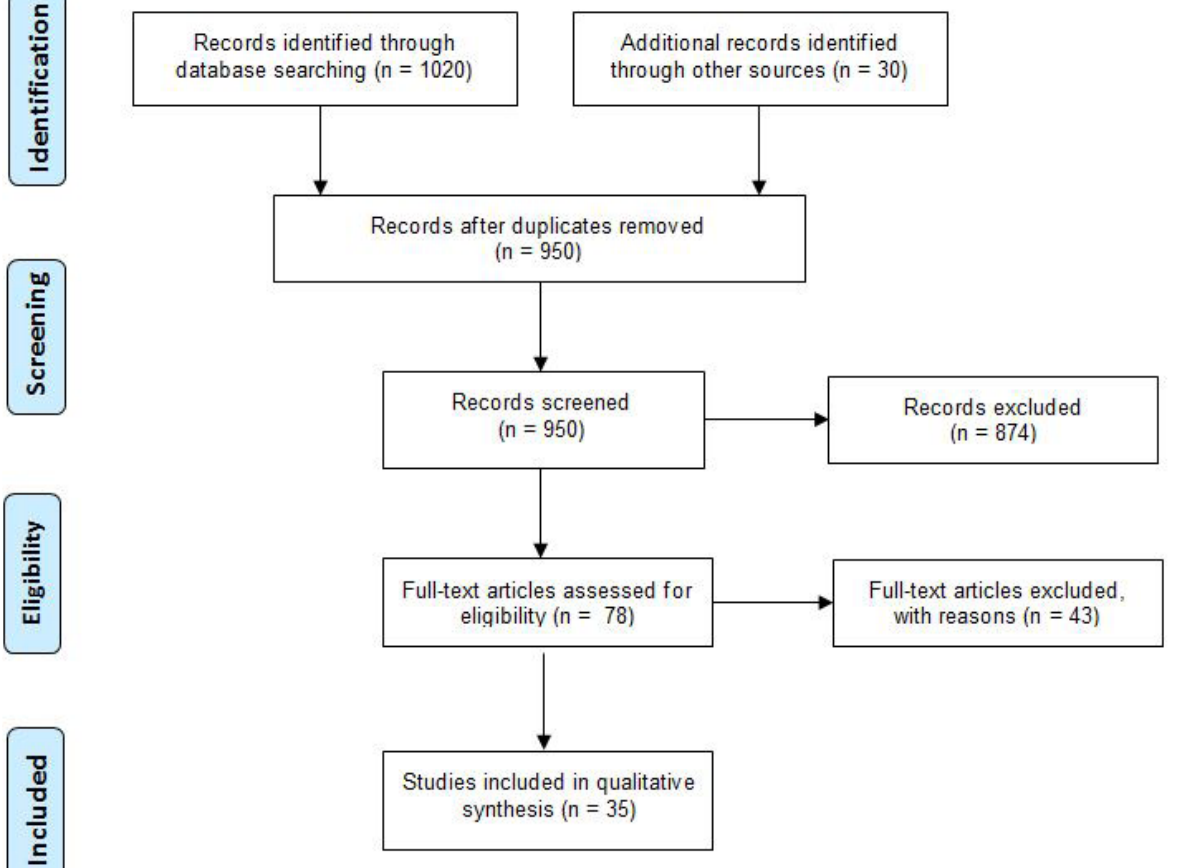
Figure. PRISM flow diagram 94 for a systematic survey of studies that looked at the effectiveness of brief interventions in emergency department patients with suspected alcohol use